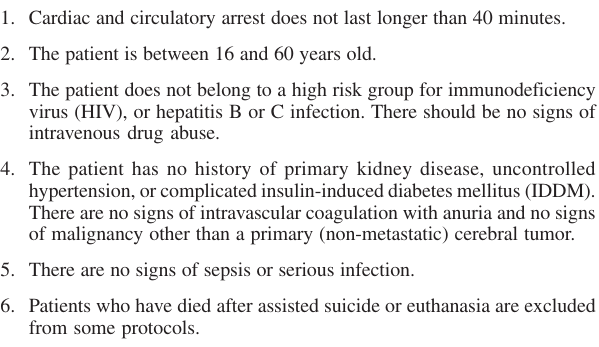
Table 2 - Criteria for exclusion of non-heart-beating donors 8